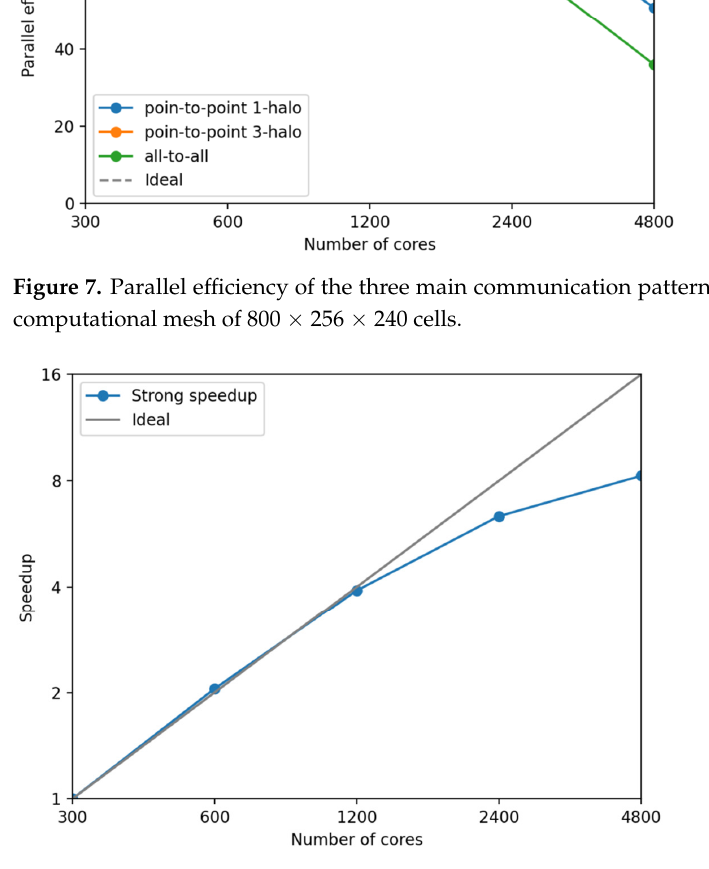
Figure 8. Strong speedup of the presented code on a computational mesh of 800 × 256 × 240 cells.